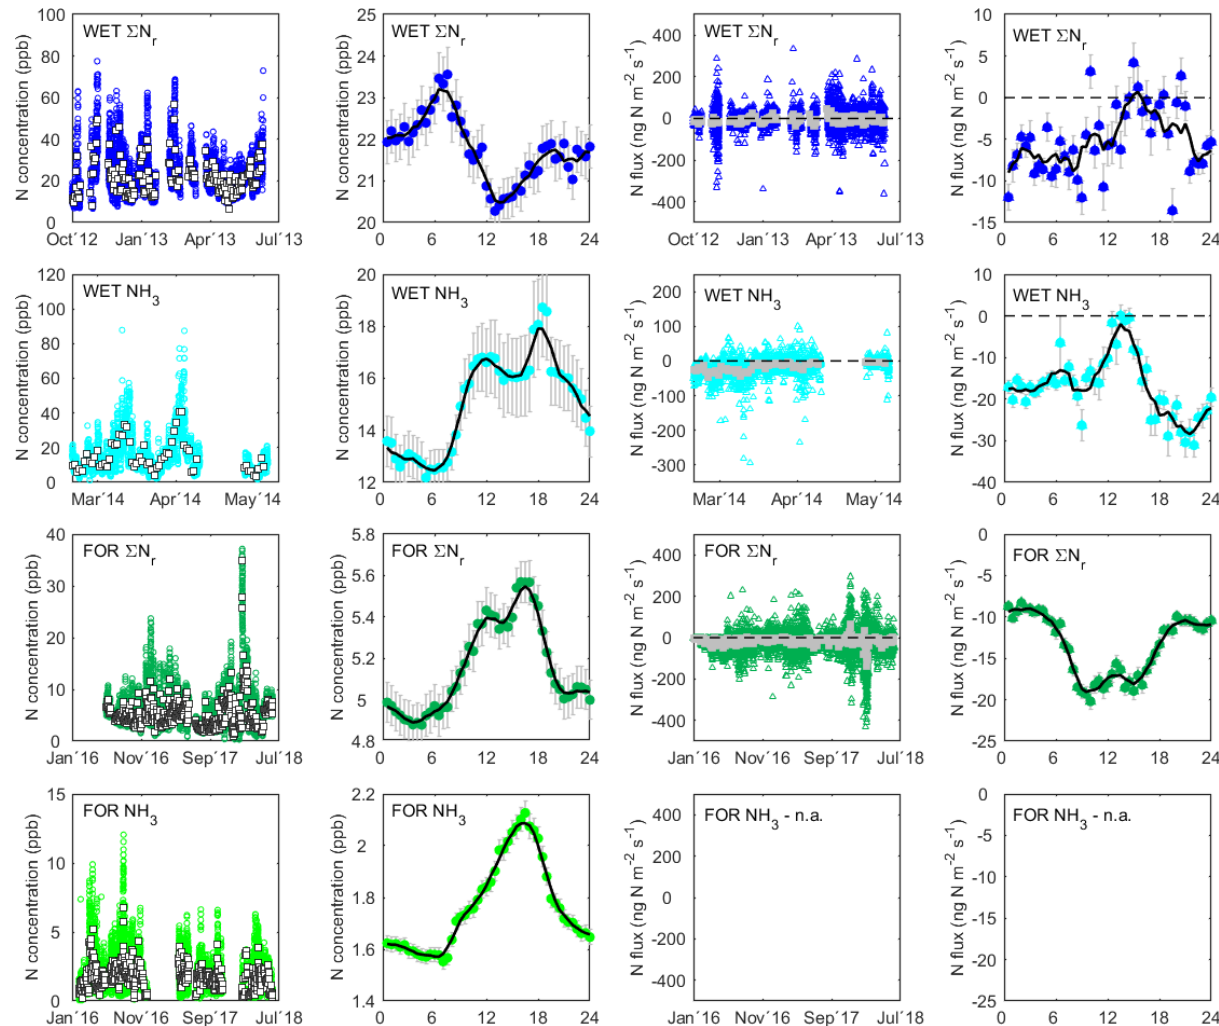
Figure 3. Campaign time series of half-hourly (coloured) and daily mean (white squares with black edges/grey squares) concentrations (first column) and fluxes (third column); the second and fourth column represent mean diurnal courses of concentrations and fluxes of the specific entire campaign period, respectively; black lines are 3h moving averages; positive flux values indicate emission, negative flux values indicate deposition of nitrogen; error bars are the standard error of the mean. Flux data shown in the third column are the gap-filled time series using the mean diurnal variation (MDV) method for the WET campaigns and the model-filled time series for the FOR campaign. See Sect. 4.3 for details. The mean diurnal flux courses in the fourth column are based on the given time series in the third column. Insufficient high-frequency variability in the low-concentration regime of ammonia measured by QCL at the FOR site made a robust covariance detection unreliable with fluxes largely under the lower detection limit of 7.75ngNm − 2 s − 1 . NH 3 fluxes at the FOR site are therefore not